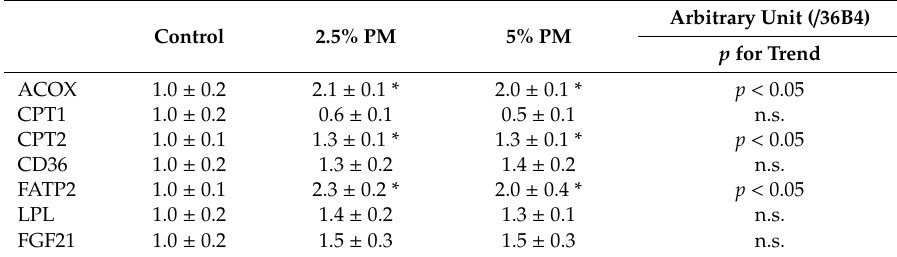
Table 9. Expression of mRNAs under the control of PPAR α in liver.